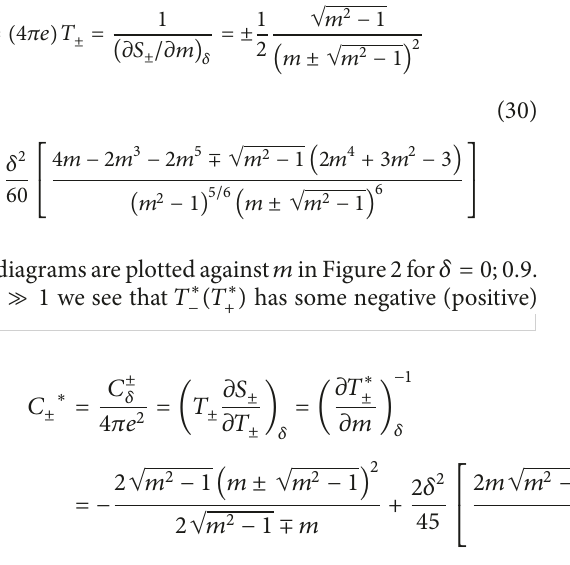
values and their sign is changed when 𝑚 󳨀→ 1 . We also plotted diagram for 𝑇 ∗ ± versus Δ𝑇 ∗ = 𝑇 ∗ + − 𝑇 ∗ − in Figure 2. They show that 𝑇 ∗ − < 0 for Δ𝑇 ∗ > 0 reaching zero value at Δ𝑇 ∗ = 0 for 𝛿 = 0, 0.9. While 𝑇 ∗ + > 0(𝑇 ∗ + < 0) , Δ𝑇 ∗ 󳨀→ 0 + for 𝛿 = 0(0.9) after that to obtain a finite positive maximum value. This maximum has smaller value for 𝛿 = 0.9 with respect to situations where we choose 𝛿 = 0.